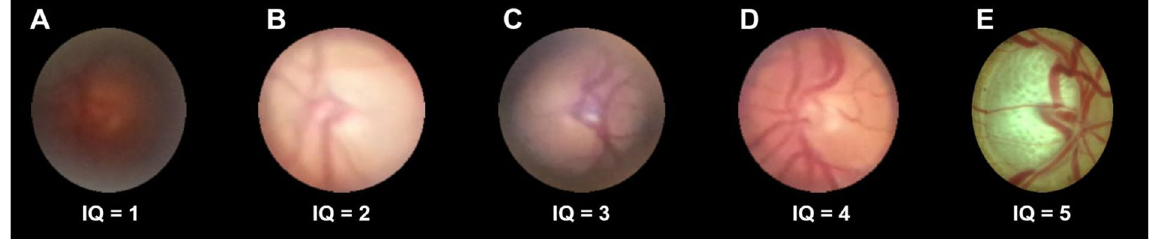
Figure 2. Image quality grading. Image quality (IQ) was graded on a 6-step-scale with these exemplary images for 0 = no fundus details visible, 1 = trail of major vessels visible ( A ), 2 = trail of medium size vessels visible ( B ), 3 = trail of some small vessels visible ( C ), 4 = trail of nearly all small vessels visible ( D ), 5 = even small vessels sharp ( E ).